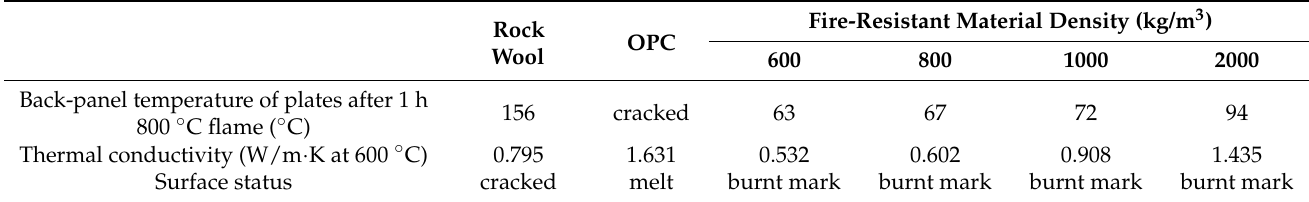
Table 6. Fire resistance characteristics of alkali-activated porous materials (Na 2 O% = 4%, W/B = 0.5, Al powder = 0.2%, LS replacement =